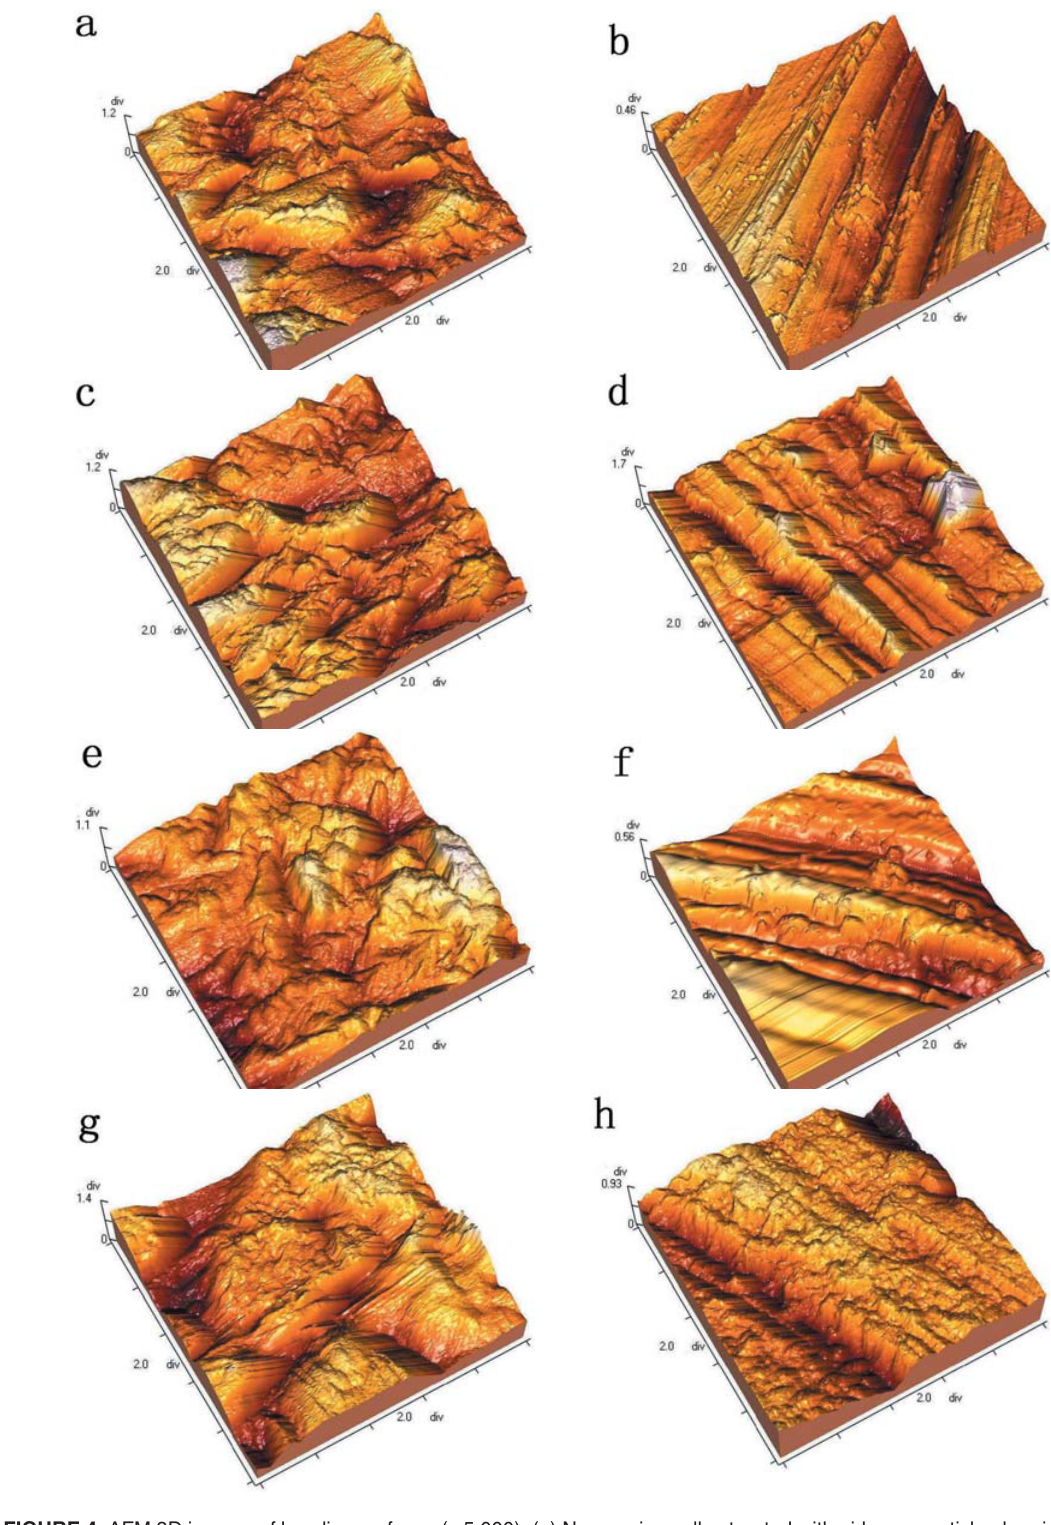
FIGURE 4- AFM 3D images of bonding surfaces (x 5,000); (a) Nonprecious alloy treated with airborne-particle abrasion (Aa), (b) Nonprecious alloy treated with #1000 SiC abrasive paper (Sp), (c) Precious alloy treated with Aa, (d) Precious alloy treated with Sp, (e) Enamel treated with Aa, (f) Enamel treated with Sp, (g) Dentin treated with Aa, (h) Dentin treated with Sp